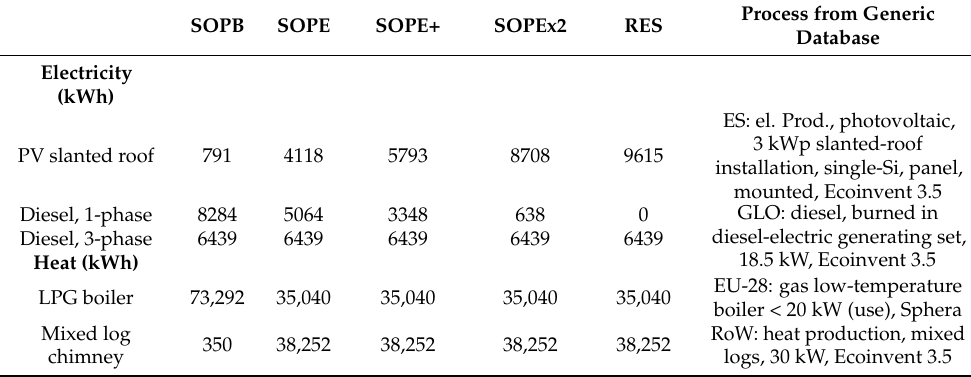
Table 3. Lifecycle inventory data for all the modelled stand-alone energy configurations for 1 year of the hut’s operation.